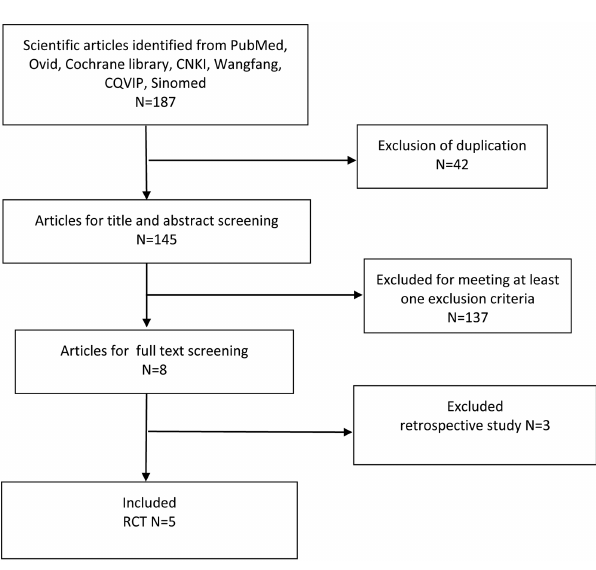
Figure 1. Flow chart of literature search and study-selection process.